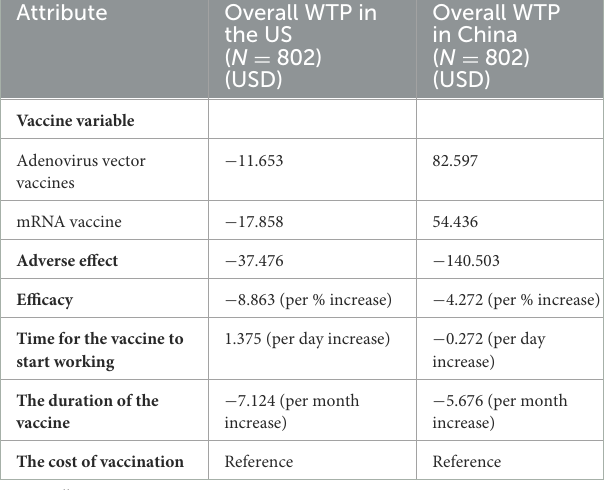
TABLE 6 Respondents WTP a in the US and